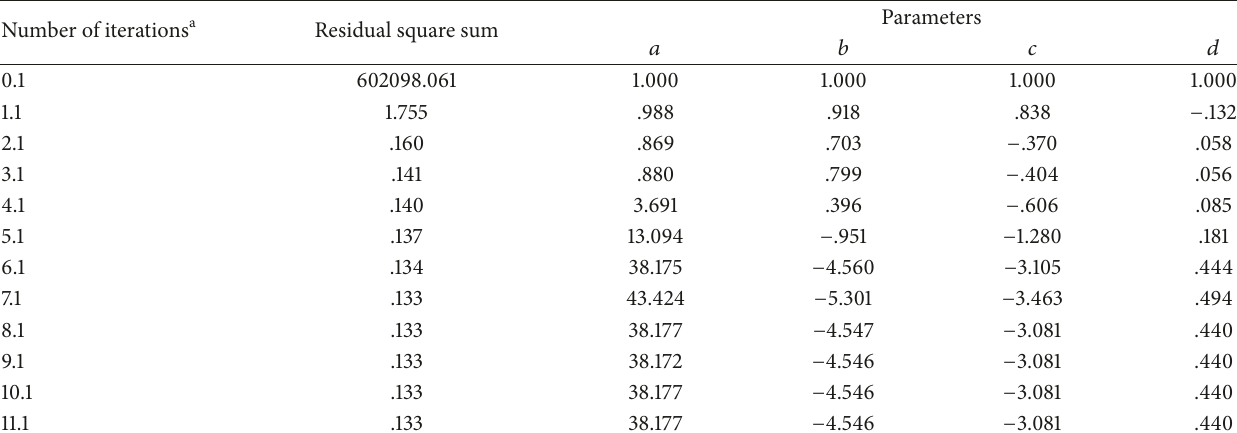
Table 7: The iteration history record b .